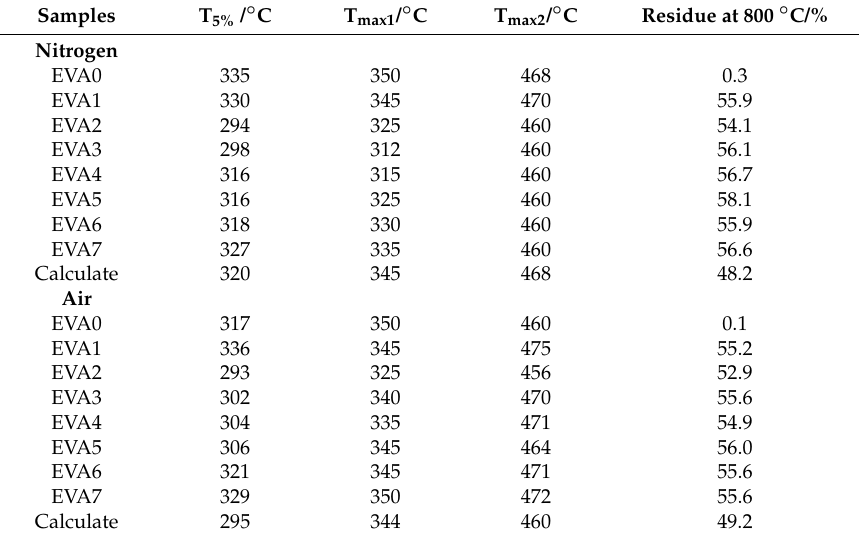
Figure 9. Experimental and calculated TG and DTG curves of ceramifiable EVA5 composites under nitrogen and air atmosphere.